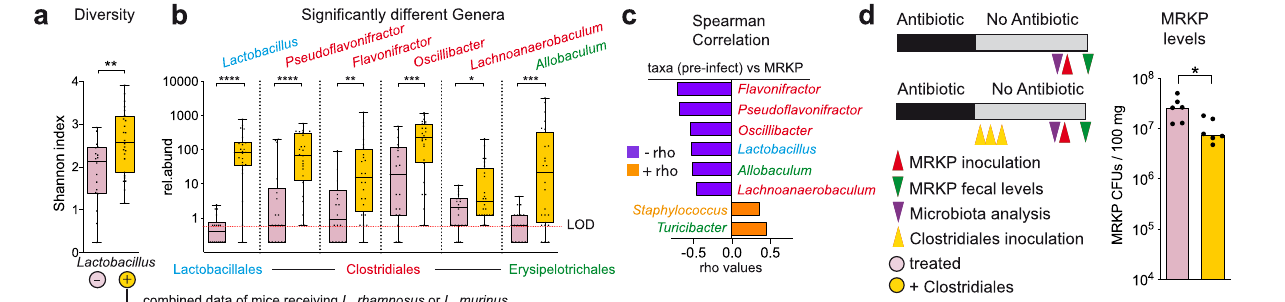
Fig.4| Lactobacillus promotetheexpansionofClostridialescommensalswhich restricts multidrug-resistant K. pneumoniae (MRKP) gut colonization in mice.